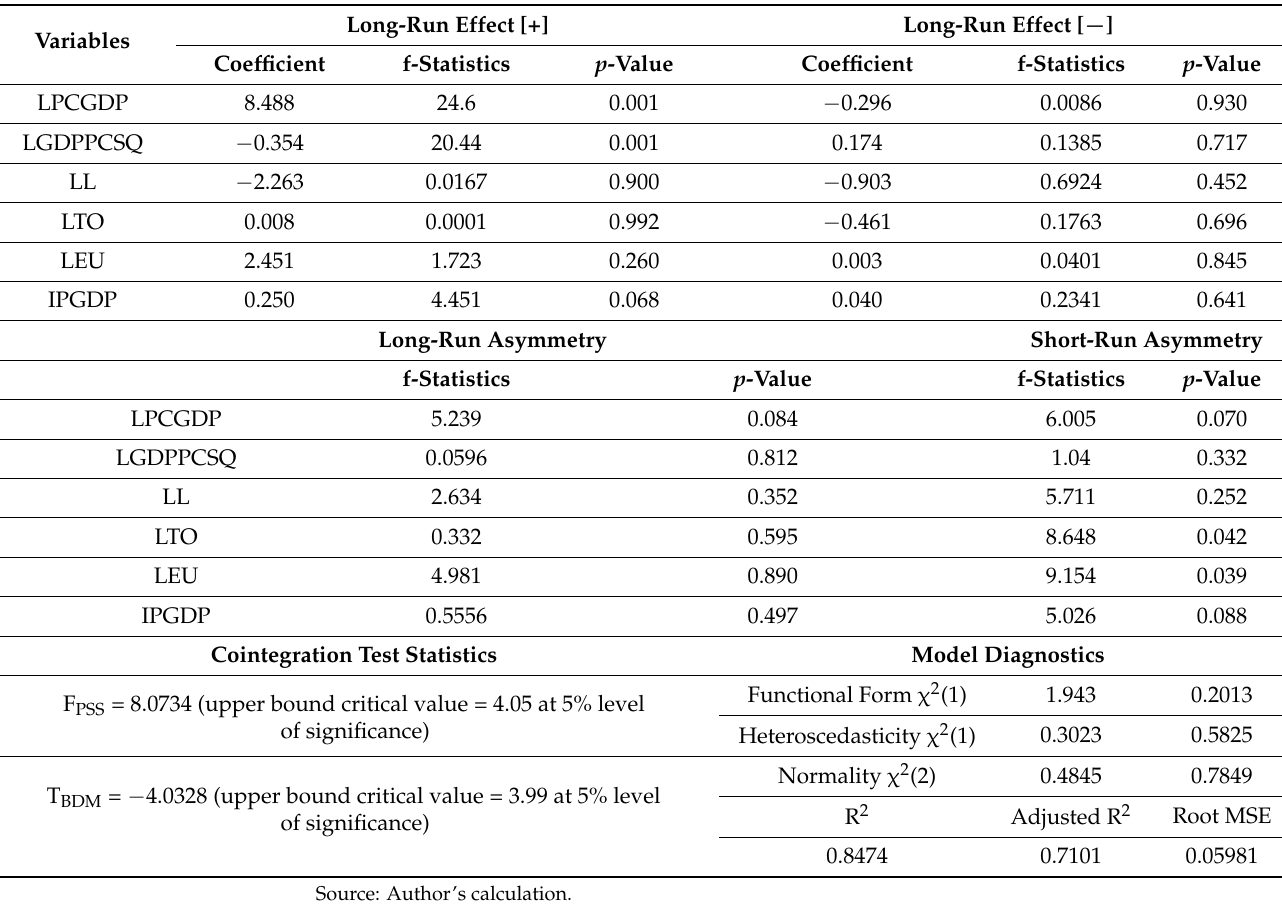
Table 4. Results of the impact of carbon emissions on Economic Development.